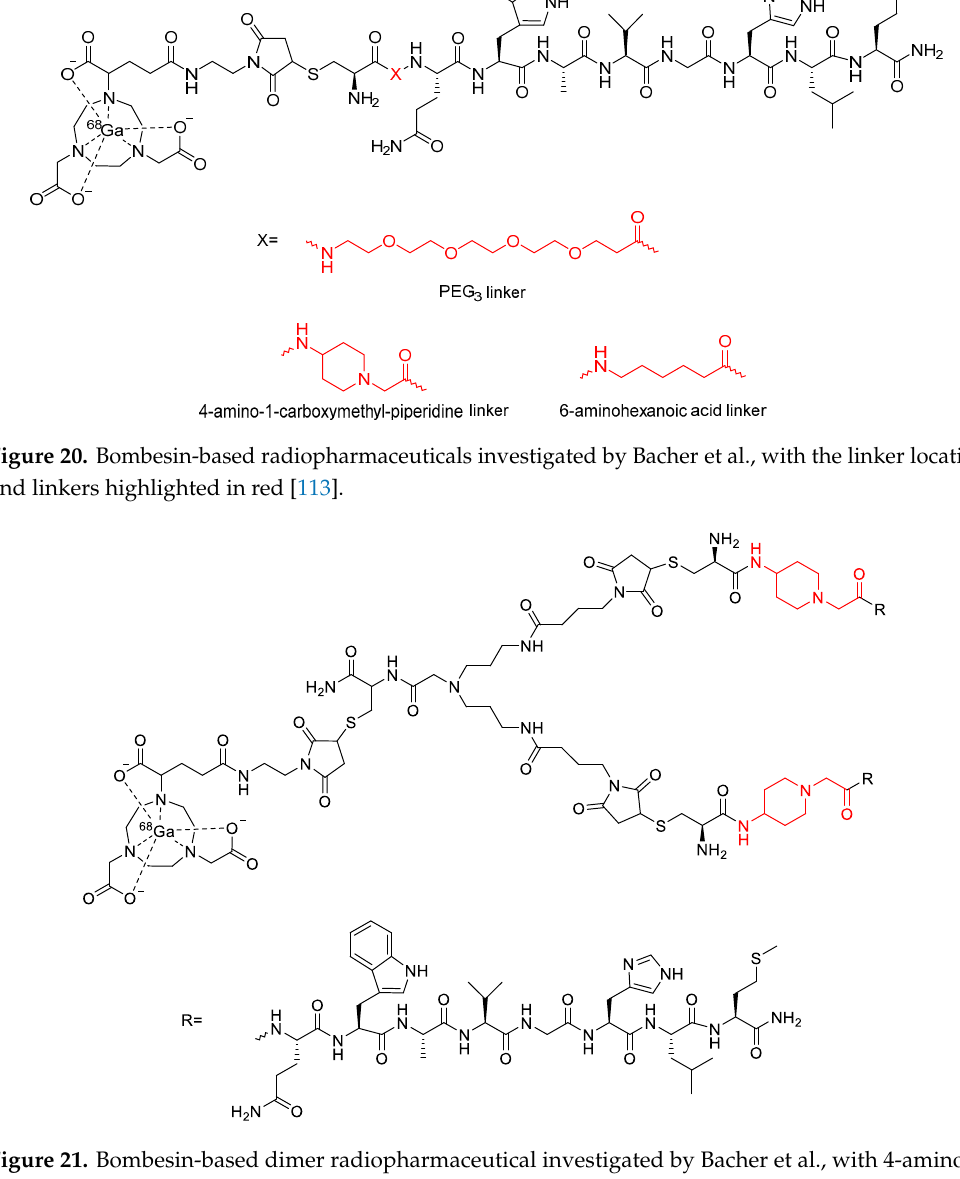
Figure 21. Bombesin-based dimer radiopharmaceutical investigated by Bacher et al., with 4-amino-1- carboxylmethyl-piperidine linkers highlighted in red